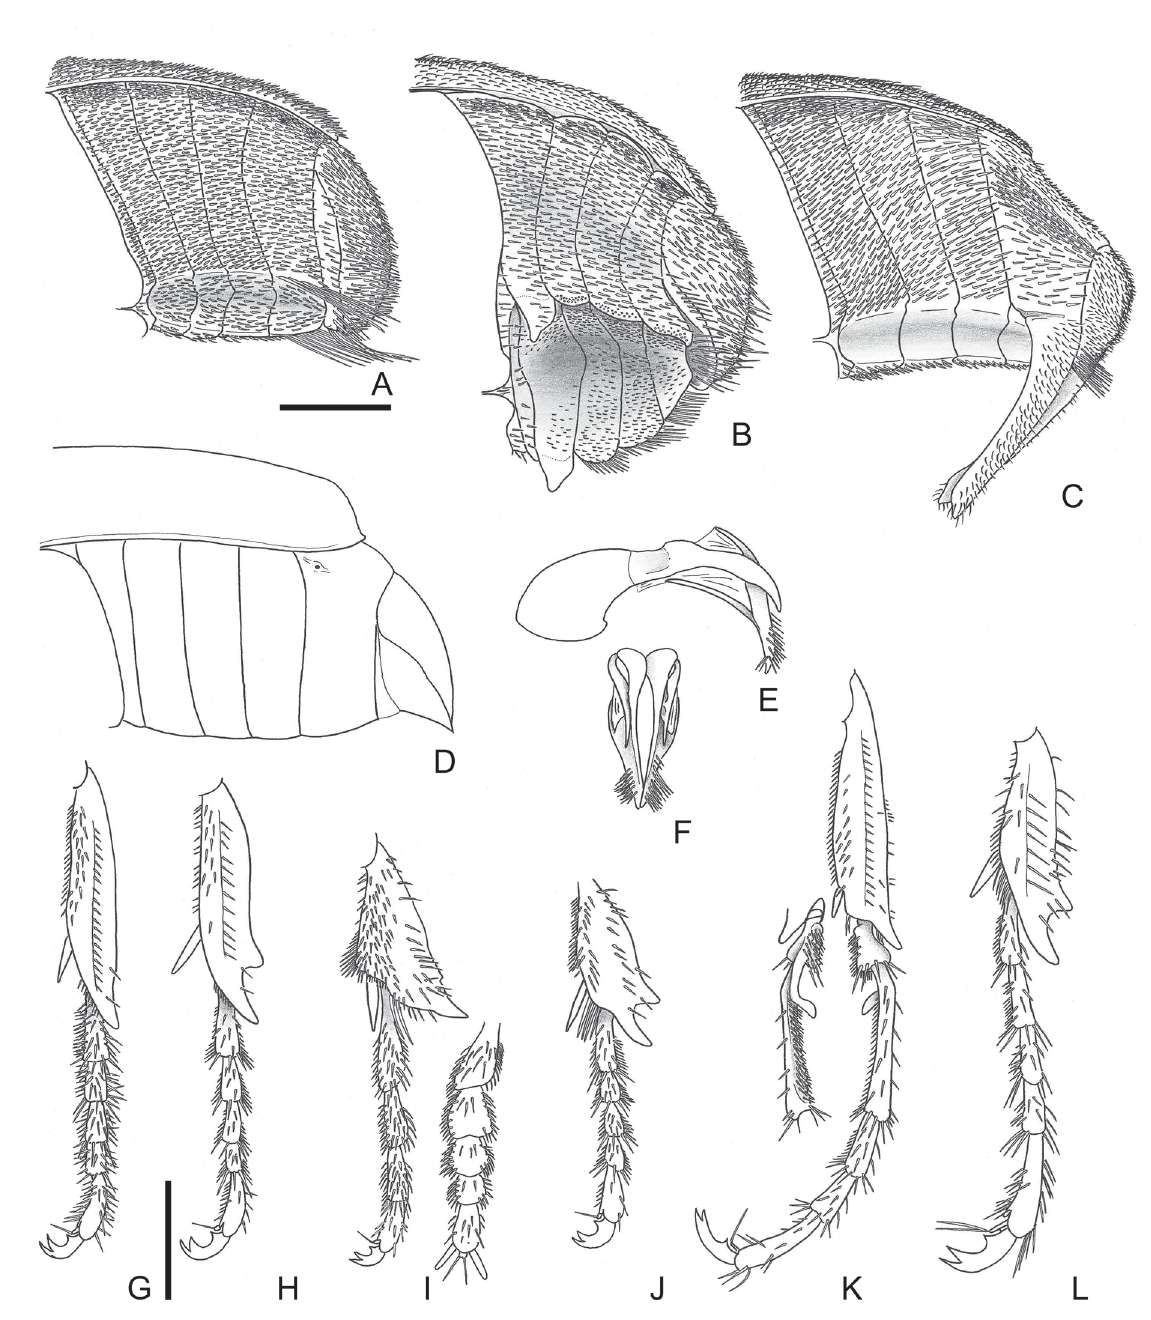
Fig. 16. Schizochelus Blanchard, 1850. A–C . Male abdomen, lateroventral. D . Female abdomen, lateral. E–F . Aedeagus (lateral, parameres apex). G–L . Protibia−tarsus (male, female) (with detail of tarsus: I = dorsal view; K = ventral view). A , E−H . Schizochelus flavescens Blanchard, 1850. B , I–J . Schizochelus bicoloripes Blanchard, 1850. C–D , K–L . Schizochelus mirabilis (Moser, 1921) comb. nov. Scale bars = 1